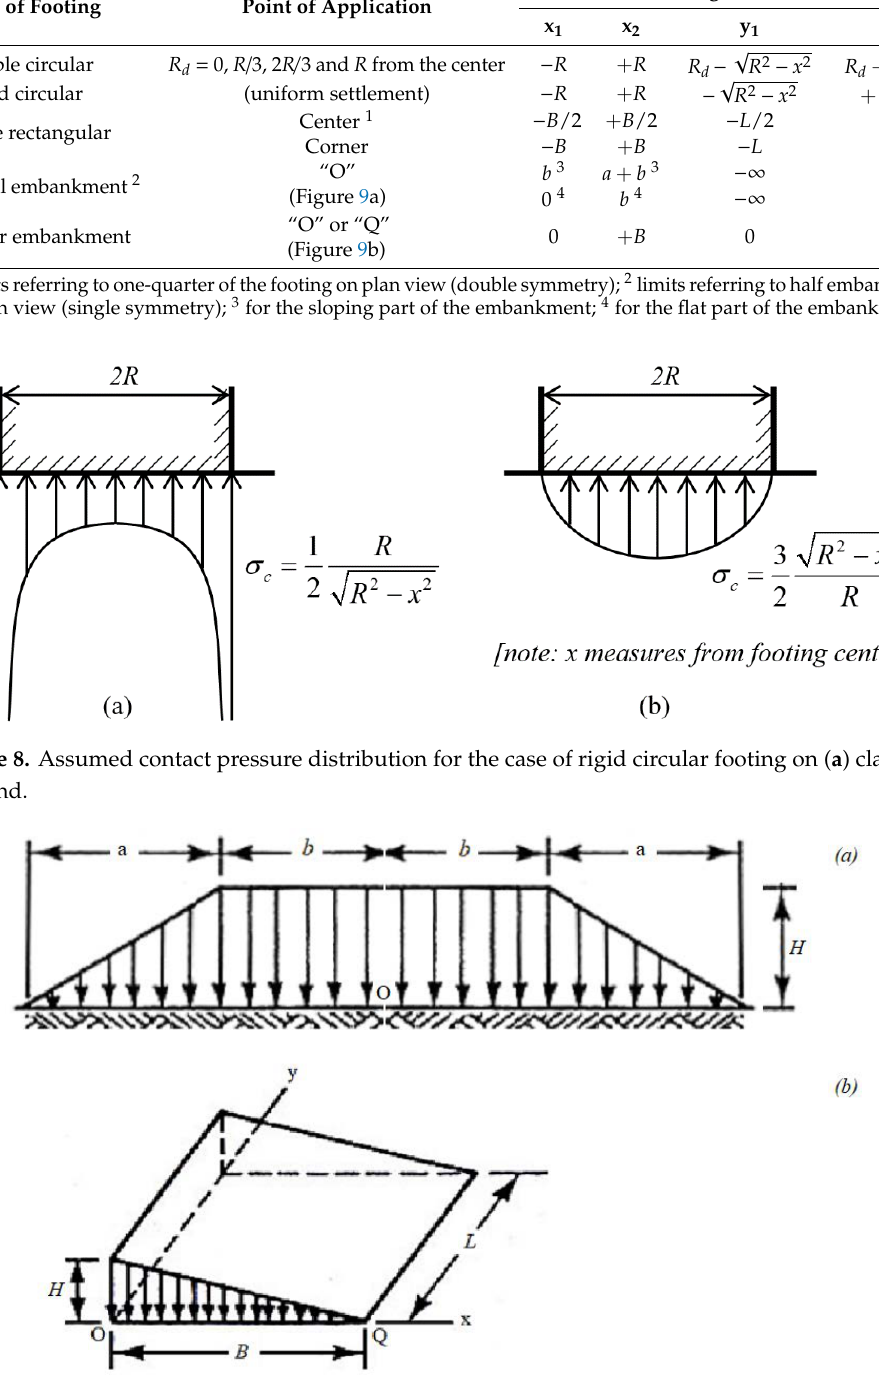
Figure 9. ( a ) Embankment loading of infinite length on both directions perpendicular to the figure and ( b ) triangular embankment loading.